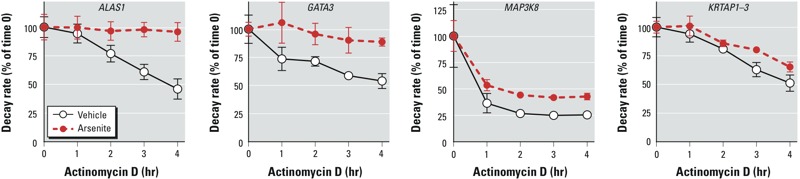
Decay rates of four probe set–identified transcripts for which the steady-state levels and decay rates were significantly different in arsenite-treated cells compared with control. Cells were treated with vehicle or arsenite for 24 hr and then treated with actinomycin D. Probe set–identified transcript levels were measured by microarray before and at 1 hr intervals after actinomycin D treatment. The starting levels of each probe set–identified transcript after 24 hr of treatment but before actinomycin D were set at 100%, and the data are expressed as mean percentages (± SD) of the average starting value (n = 4 biological replicates per group). In all cases, the decay curves were significantly different between control and arsenite-treated cells by both the ORIOGEN and EDGE methods (p < 0.05). The Affymetrix probe set identifiers for the transcripts shown are as follows: ALAS1, 205633_s_at; GATA3, 209602_s_at; MAP3K8, 205027_s_at; and KRTAP1‑3, 234880_x_at.